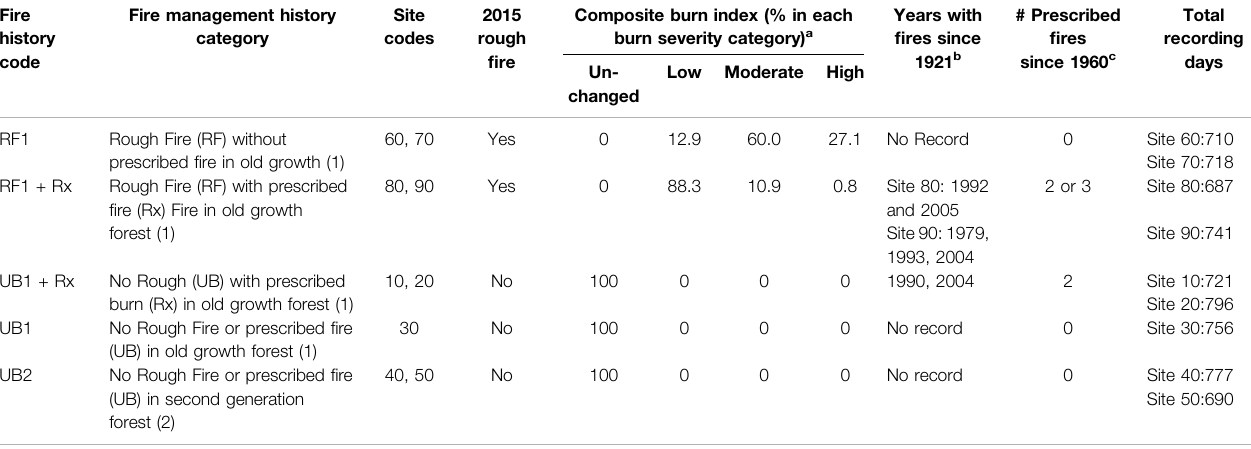
TABLE 1 | Fire history conditions and recording days at each acoustic monitoring site ( N =